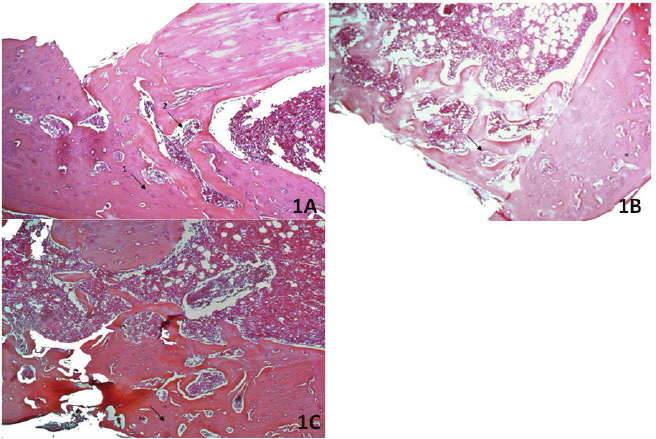
FIGURE 1 - Light microscopy findings at 30 days postoperatively, approximately 100x magnification, hematoxylin and eosin (HE) stain.